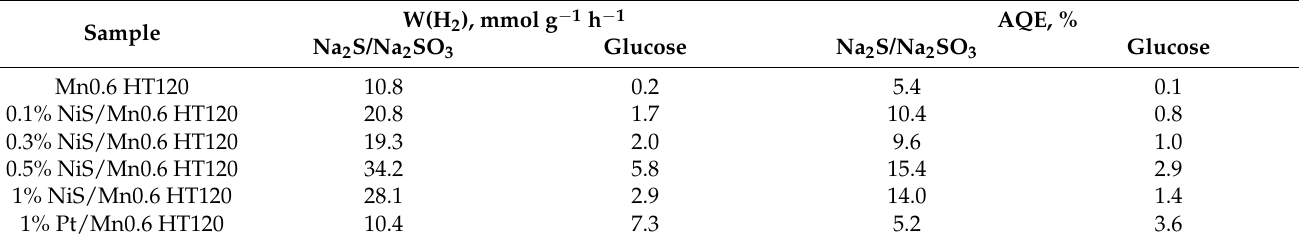
Table 3. The rate of photocatalytic hydrogen evolution for different photocatalysts.